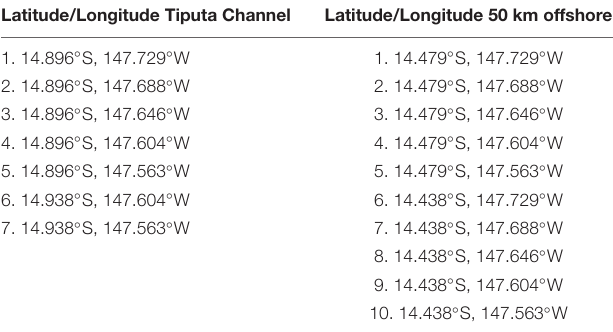
the same instrument as chlorophyll-a using the 8-day, 4-km data product near Tiputa Channel. TABLE 1 | Latitude and longitude of MODIS data near Tiputa Channel and approximately 50 km offshore of Tiputa Channel. Latitude/Longitude Tiputa